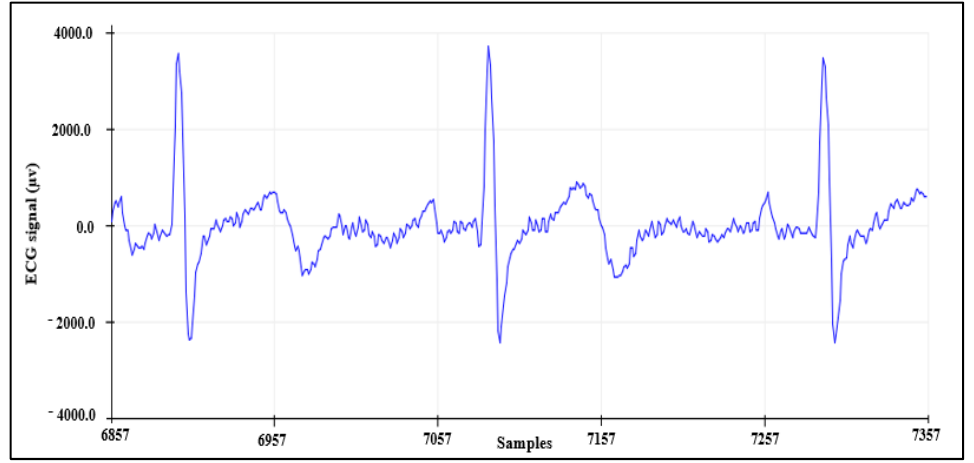
Figure 10. ECG signal collected using AFE.